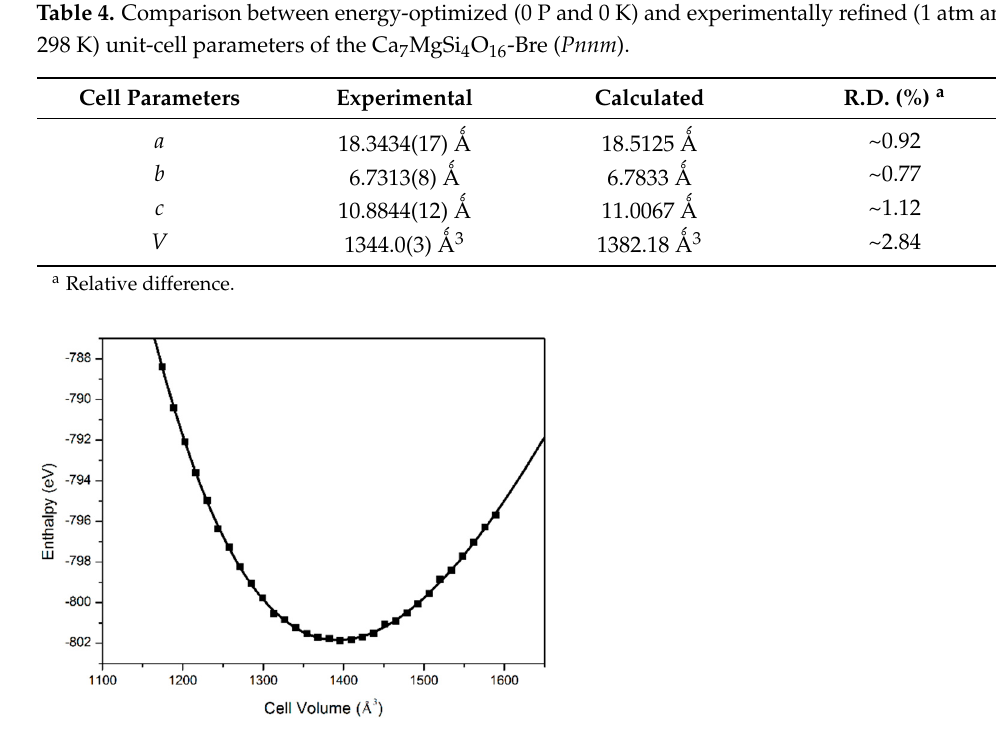
is the first pressure 0 is not fixed, B 0 is 90.6(4) 0